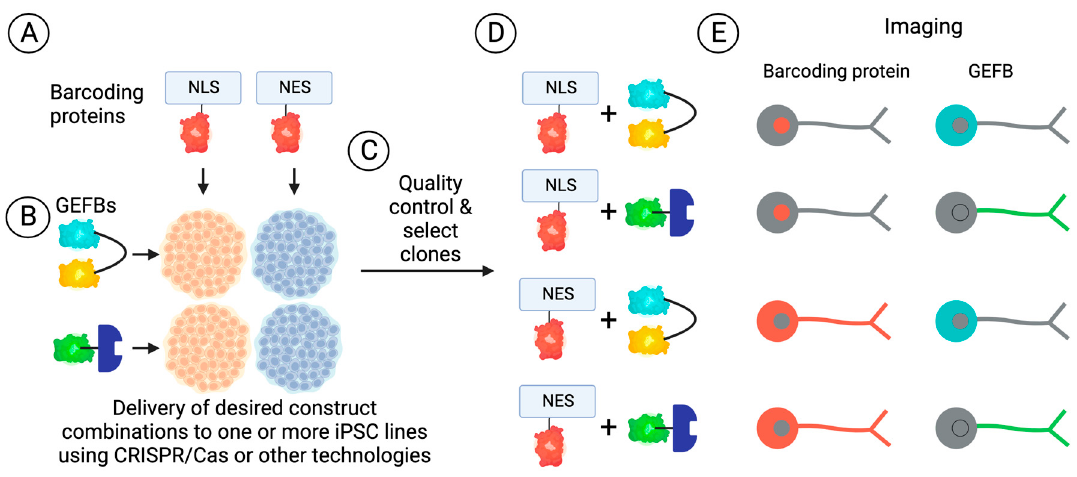
Figure 3. Overview of GEFB and barcoding protein knock-in to iPSCs for attaining multiplexed biosensor cell populations. iPSCs are modified to express barcoding proteins ( A ) or GEFBs ( B ) in pre-defined combinations, which following standard quality control steps for gene edited pluripotent stem cells ( C ), yielding cell populations for downstream experimentation ( D ). Imaging of barcoding proteins and GEFBs in iPSC-derived cell types can produce distinct patterns of fluorescence intensity and localization ( E